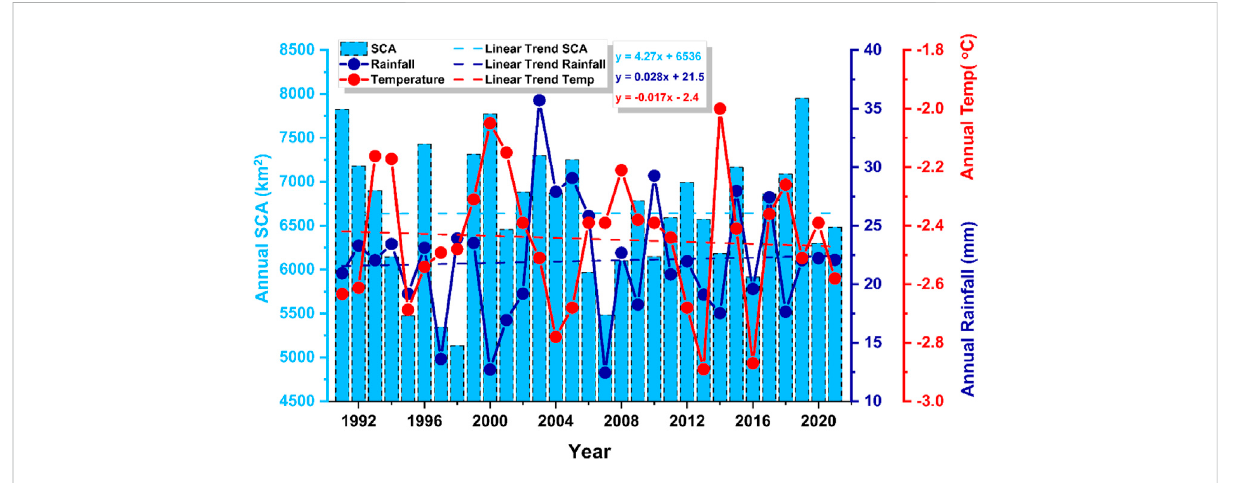
FIGURE 8 Annual SCA, rainfall, and temperature of Shigar.